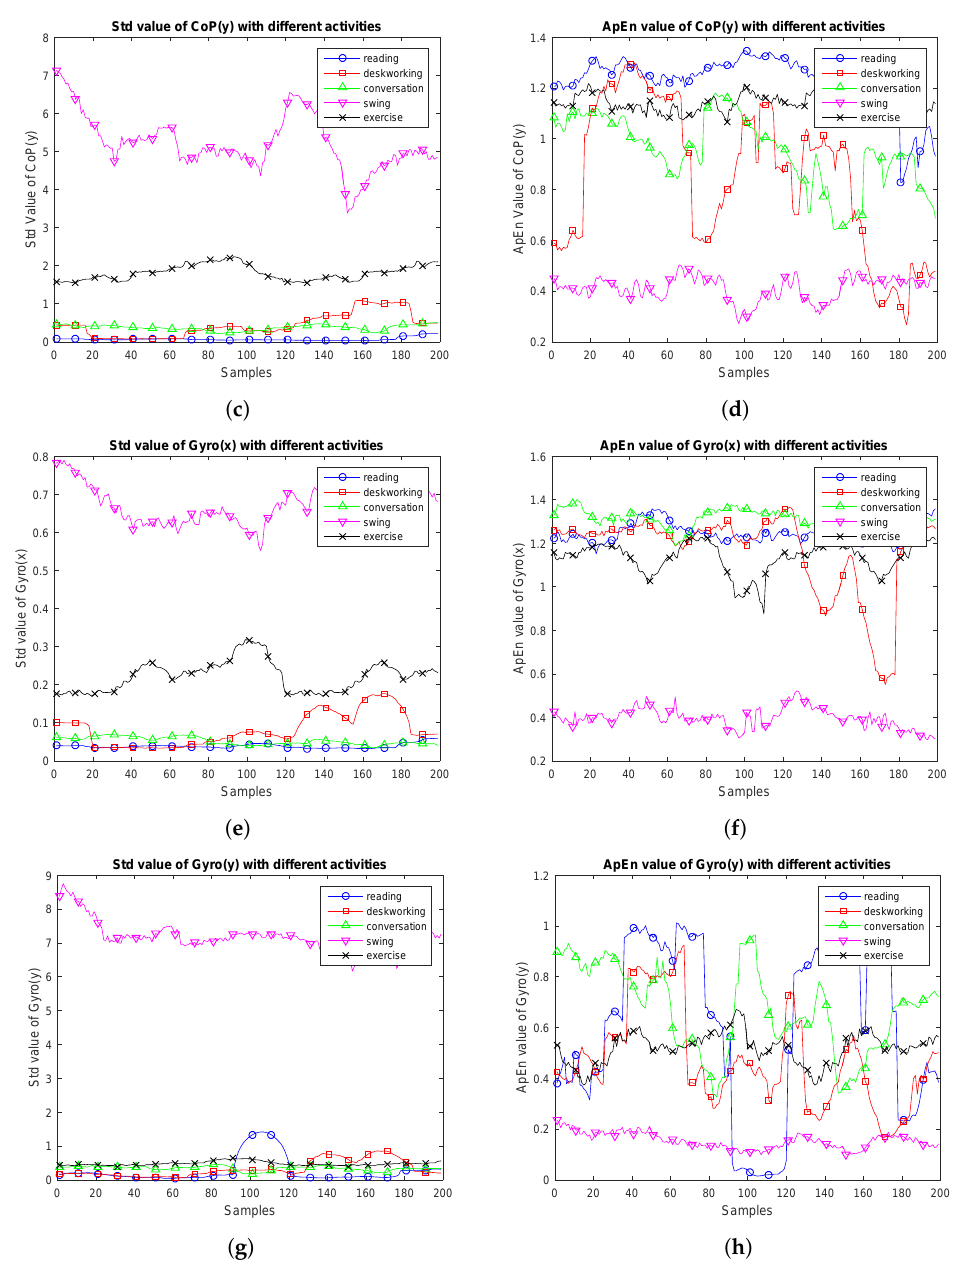
Figure 6. Feature distribution of each